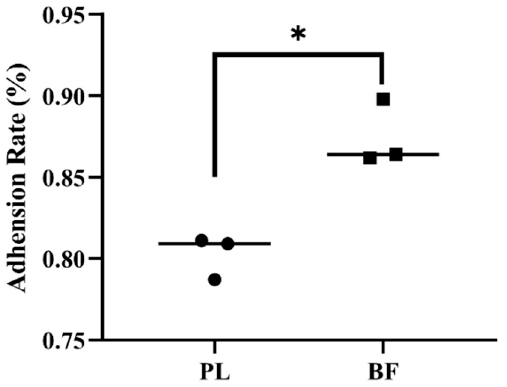
Figure 2. Adhesion rates of L. plantarum Y42 in the biofilm (BF) and planktonic (PL) states on HT-29 cell monolayers; *: p < 0.05. All data are presented as mean ±